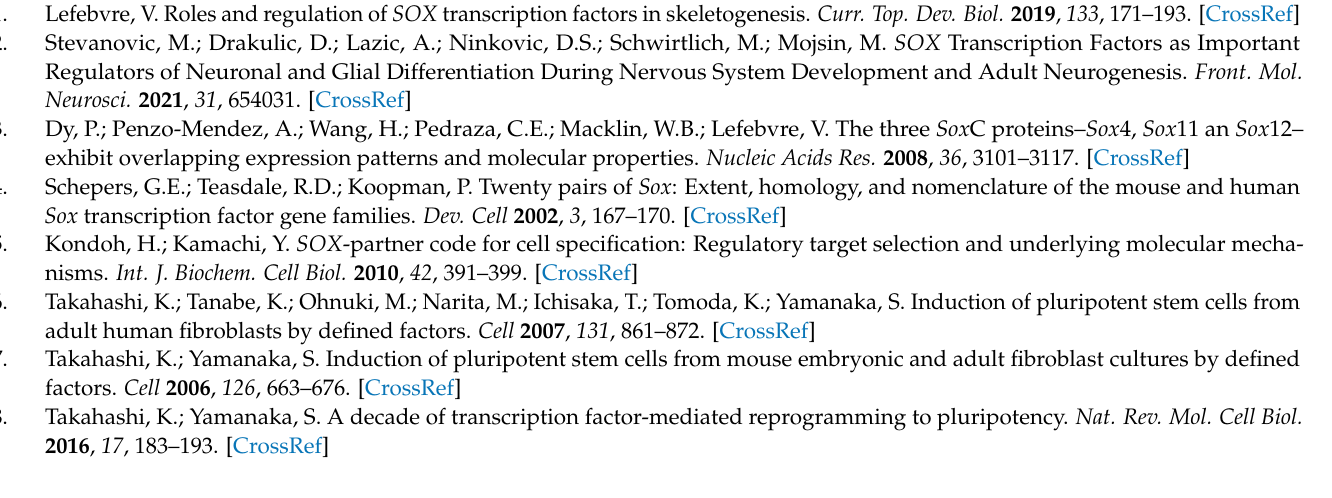
Table S4: Gene ontology: biological processes, molecular function and cellular components of Sox genes in Bos sp.